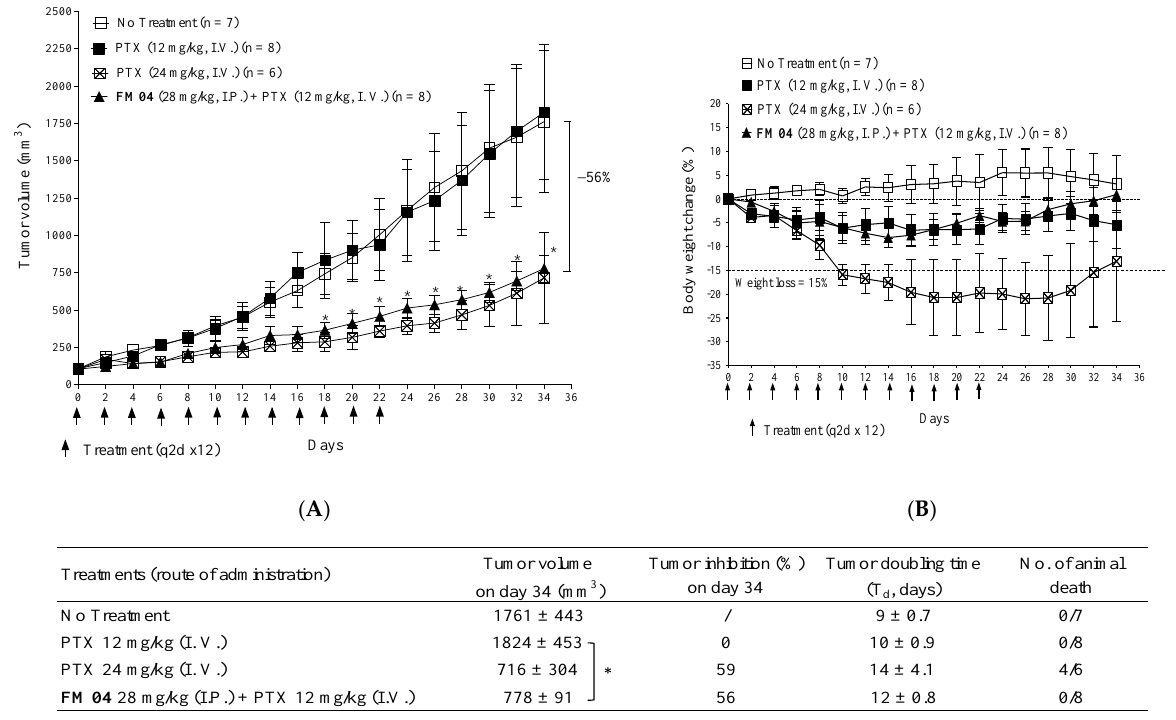
Figure 5. In vivo efficacy study of FM04 on reversing P-gp-mediated PTX resistance in human melanoma MDA435/LCC6MDR xenograft model. Balb/c nude mice were subcutaneously xenografted with LCC6MDR. The treatment groups included (1) control — no treatment, (2) PTX (12 mg/kg, I.V.) alone, (3) PTX (24 mg/kg, I.V.) alone and (4) co-treatment: FM04 (28 mg/kg, I.P.) was injected 1 hr prior to PTX (12 mg/kg, I.V.). ( A ) tumor volume and ( B ) body weight were monitored throughout the treatment. The treatment was given to mice every other day for 12 times (q2d × 12) and indicated as an arrow. The values were presented as mean ± standard error of mean (n = 6 – 8 mice per group). ( C ) Tumor-inhibition % on day 34 and tumor-doubling time after each treatment were determined. Number of animal deaths was monitored during the treatment. For the tumor volume at each time point, statistical analysis was conducted by one-way-ANOVA between co-treatment group and PTX alone treatment, * p < 0.05. /: not